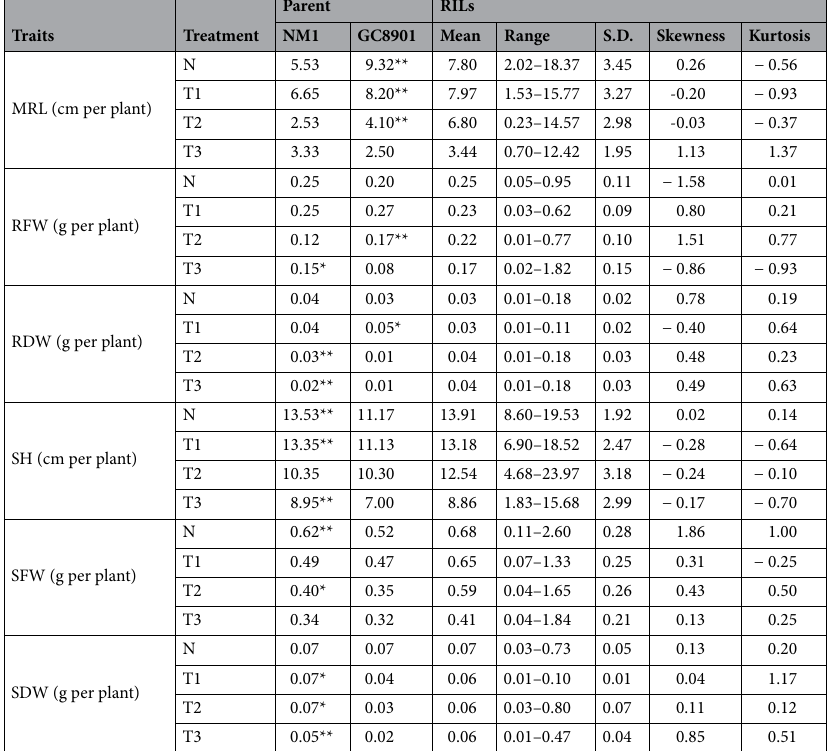
Table 2. Phenotypic performance for traits related to seeding growth of the two parents and RIL population under different salt treatments. MRL Main root length; RFW Root fresh weight; RDW Root dry weight; SH Seeding height; SFW Seeding fresh weight; SDW Seeding dry weight; N, T1, T2 and T3 were 0, 50, 100 and 200 mM NaCl, respectively. * and **Means significant at the 0.05 and 0.01 probability levels, respectively.